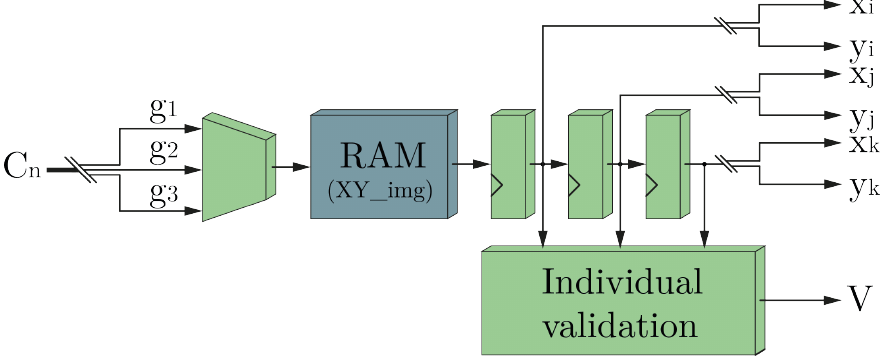
Figure 4. Block diagram for individual decoding and